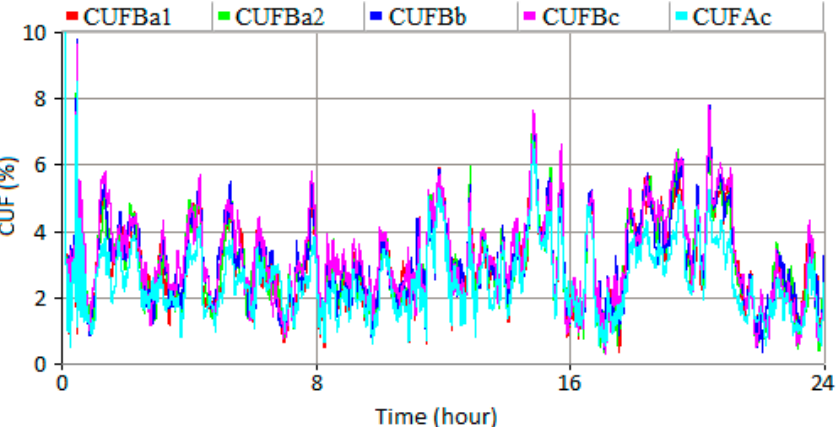
Figure 25. CUF comparison at PCC for cases Ac, Ba-Time, Ba-Accuracy, Bb and Bc.